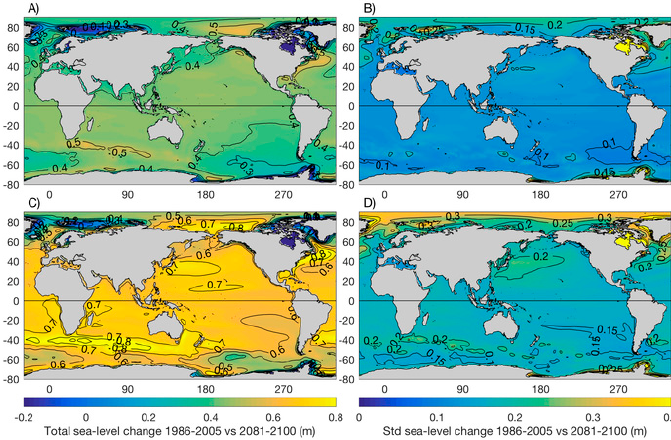
Figure 4. regional variability of SLR and their uncertainties (1-standard deviation) in the RCP 2.6 ( A , B ) and RCP 8.5 ( C , D ) scenarios (data: IPCC AR5 Ch13 [20]).